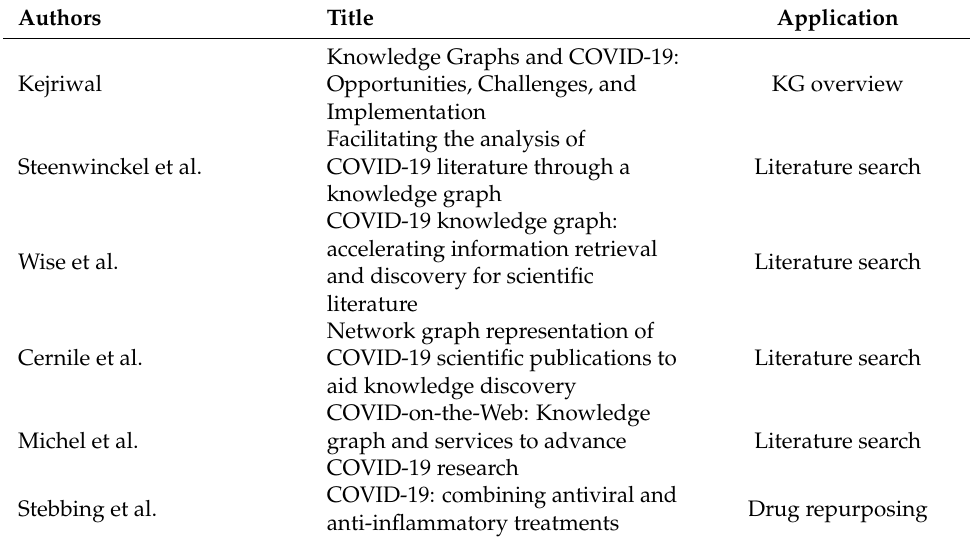
Table 1. Summary of papers resulting from our literature